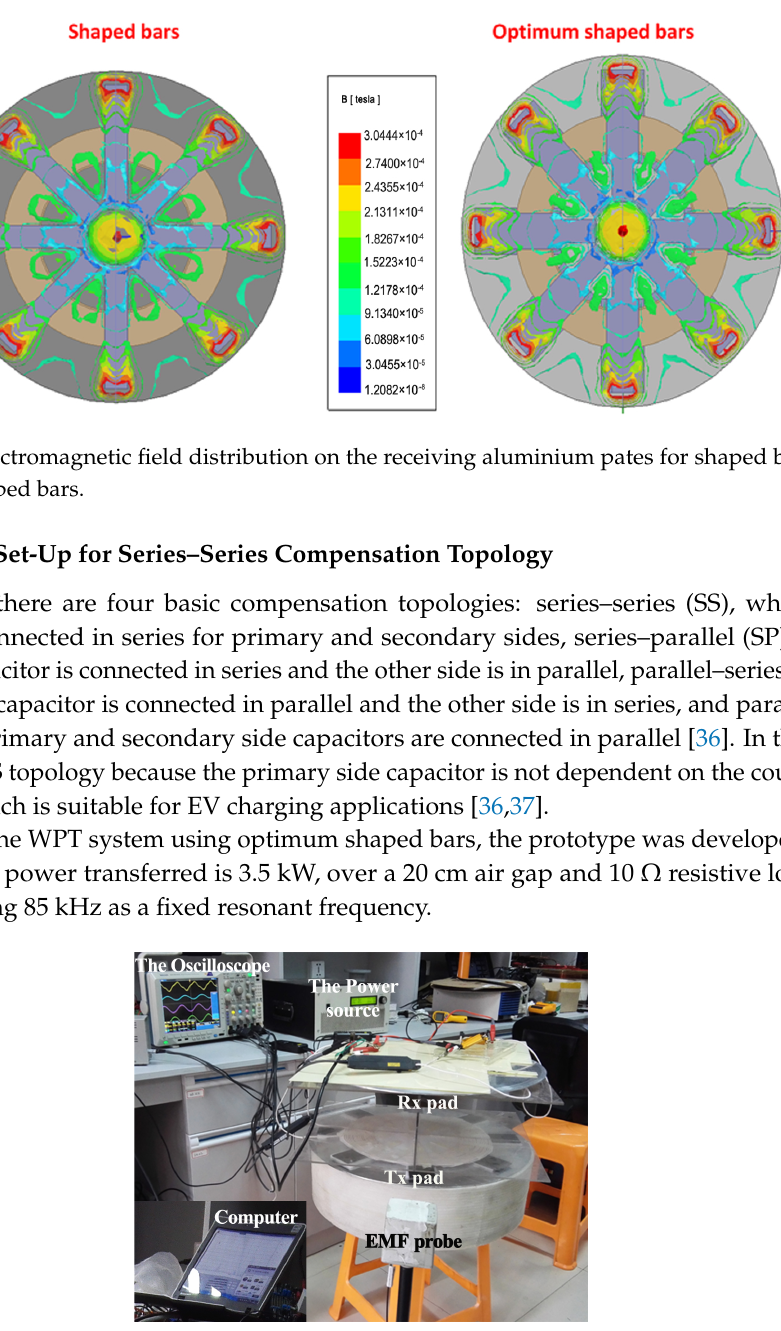
Figure 18. Experimental